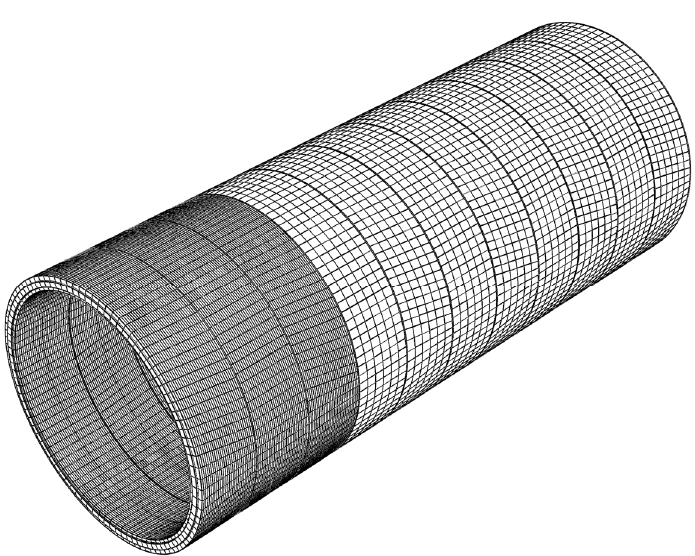
Figure 3. Tunnel model.